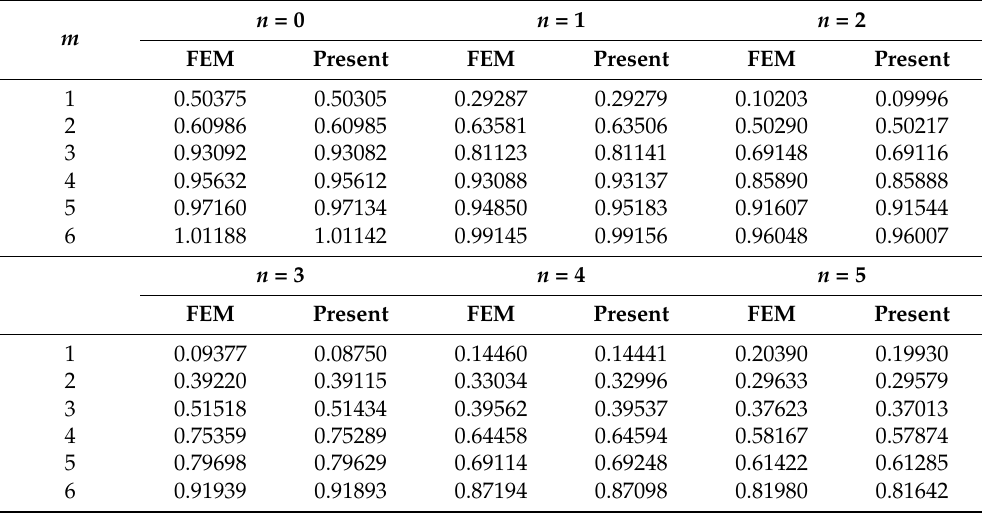
Table 2. Comparison of dimensionless frequencies for non-rotating isotropic combined conical- cylindrical shell with F-C boundary condition ( µ =